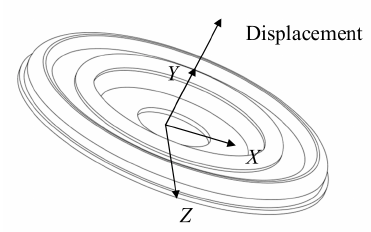
Figure 11. Driving direction of RD